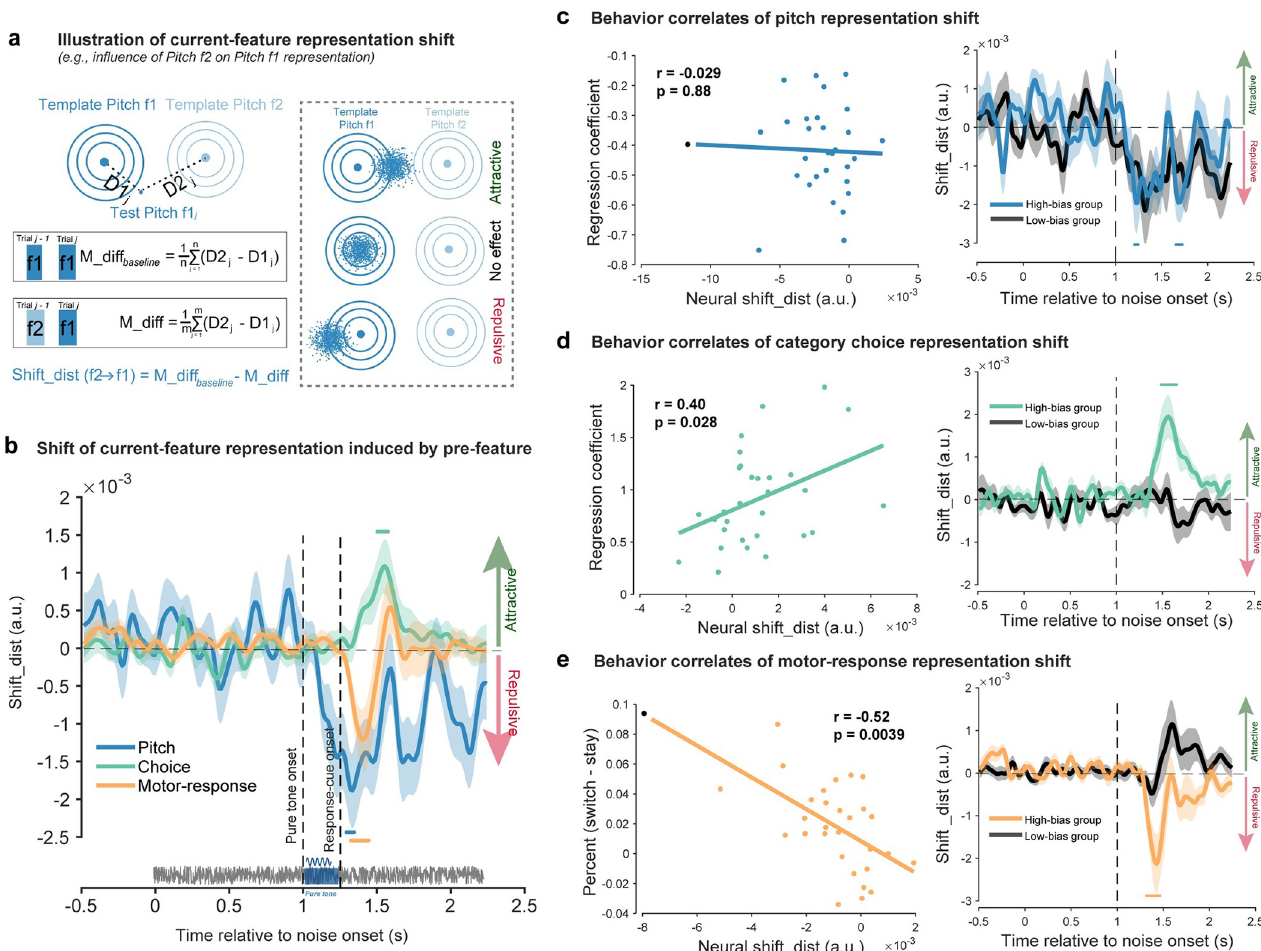
Fig 3. Direct neural evidence for serial bias and its behavioral relevance. (A) Illustration of neural representational shift analysis. Left: Influence of previous f2 on current f1 as an example. Neural templates were built for f1 (dark blue circle) and f2 (light blue circle) base on the k-fold cross validation process. For each trial with current f1 and previous f2, its neural distance to template f1 and template f2 were computed, resulting in D1, D2, and their difference M_diff (D2-D1). As baselines, trials that have current f1 but previous f1 were selected and were analyzed using the same analysis, resulting in M_diff baseline . The difference between M_diff baseline and M_diff (Shift_dist) characterizes the neural representational shift in f1 by prior f2. Right: Neural representation of current-trial f1 is attracted toward (upper, positive Shift_dist values), repulsed from (lower, negative Shift_dist values), or not affected (middle, around zero Shift_dist values) by prior f2. ( B ) Grand average neural representational shift (Shift_dist) as a function of time following white noise onset, for pitch (blue), category choice (green), and motor response (orange). Positive and negative values correspond to attractive and repulsive direction, respectively. Horizontal colored lines denote significant temporal clusters (cluster-based permutation test, two-sided, corrected, p < 0.05) for each feature. Shadows represent SEM. ( C-E ) Behavioral correlates of neural shift. Left: Scatterplot of behavioral bias vs. neural shift for pitch ( C ), category choice ( D ), and motor response ( E ). Neural representation shift is the mean shift_dist across significant clusters in B. Serial bias behaviors for pitch, category choice, and motor response are indexed by regression coefficients of past pitch, past category choice, and difference between “switch” and “stay,” respectively. Each dot represents individual participant, with black dots denoting excluded participants as outliers. Right: Participants were divided into two groups based on the serial bias behavior in pitch, category choice, or motor response, respectively. Grand average neural representational shift (Shift_dist) of High-bias (colored lines) and Low-bias (black line) groups for pitch ( C ), category choice ( D ), and motor response ( E ). Horizontal colored lines denote significant temporal clusters (cluster-based permutation test, one- sided, corrected, p < 0.05). Data supporting this figure found here: